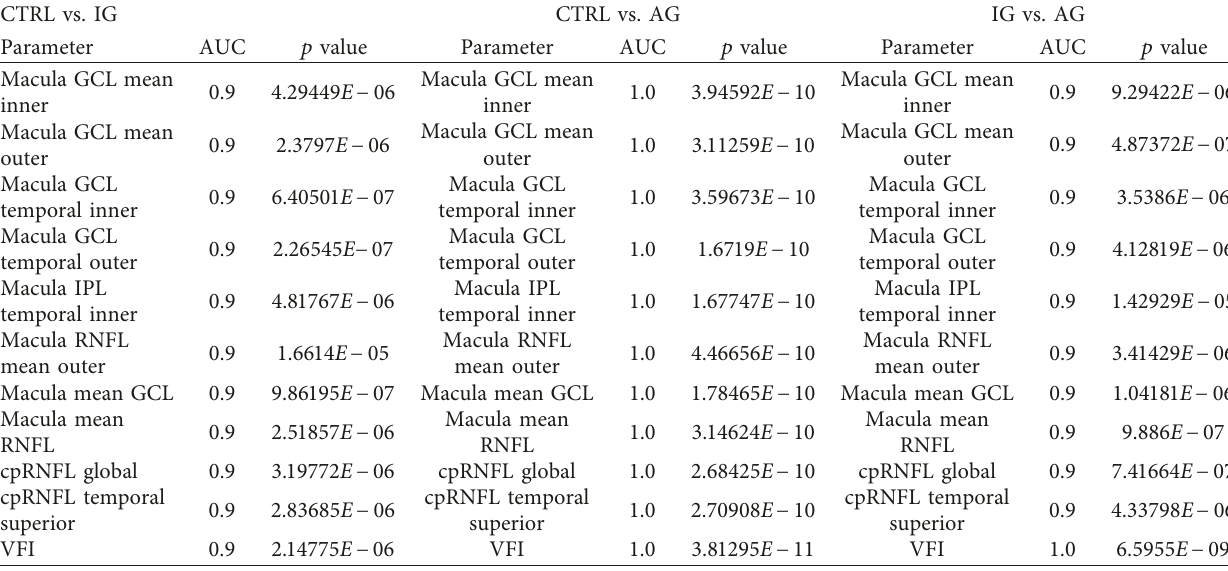
Table 1: Mann–Whitney and AUC of the parameters with the highest diagnostic ability in the CTRL vs. IG, CTRL vs. AG, and IG vs. AG